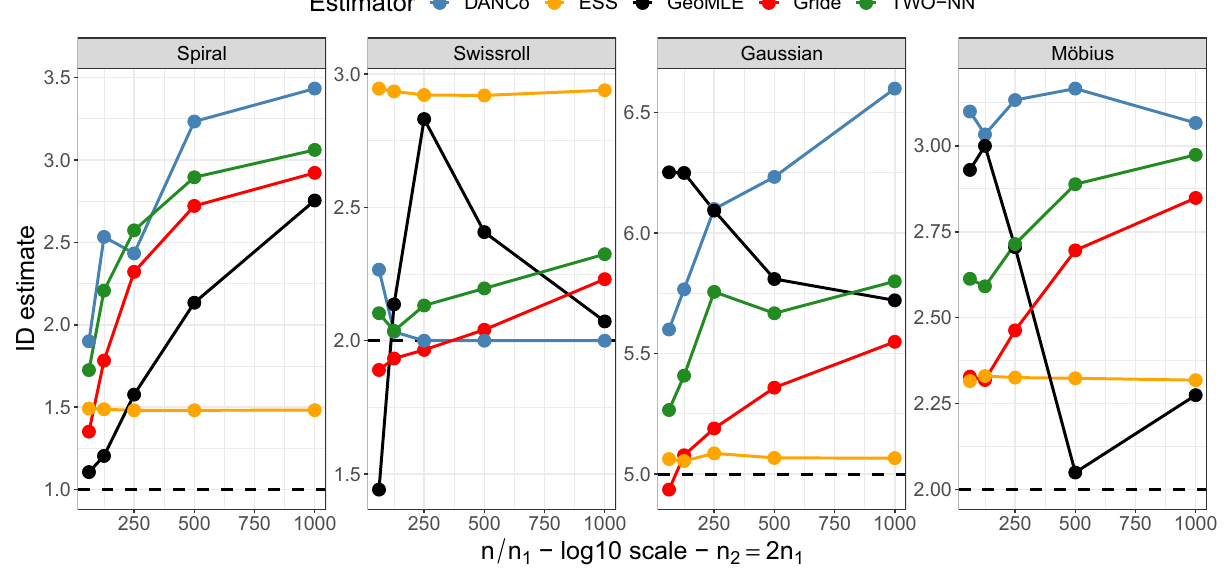
Figure 7. Evolution of the estimates of the id of the Spiral , Swissroll , Gaussian , and Möbius datasets computed via DANCo , GeoMLE , ESS , TWO-NN , and Gride while varying the considered neighborhood size.